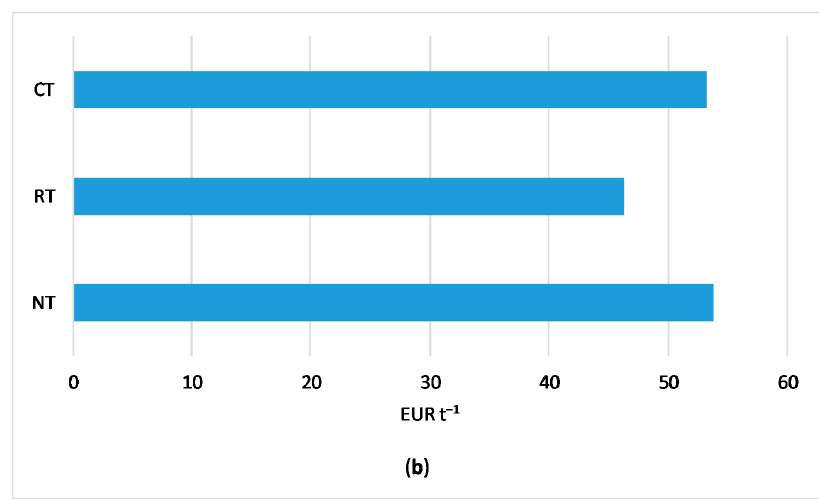
Figure 8. Life-cycle costs of maize production in conventional tillage (CT), reduced tillage (RT) and no-tillage (NT): ( a ) per one hectare of area; ( b ) per one ton of grain. Among the analyzed technological operations in the grain maize production, the processes of mineral fertilization (from 36.7% in CT to 41.7% in RT), soil cultivation and sowing (from 31.2% in RT to 37.6% in CT) had the most significant share in shaping life-cycle costs (Figure 9). This resulted from the costs of mineral fertilizers, fuel, and machinery. Processes of harvesting and plant protection were of less importance (their shares were not higher than 17% in RT and 14% in CT).